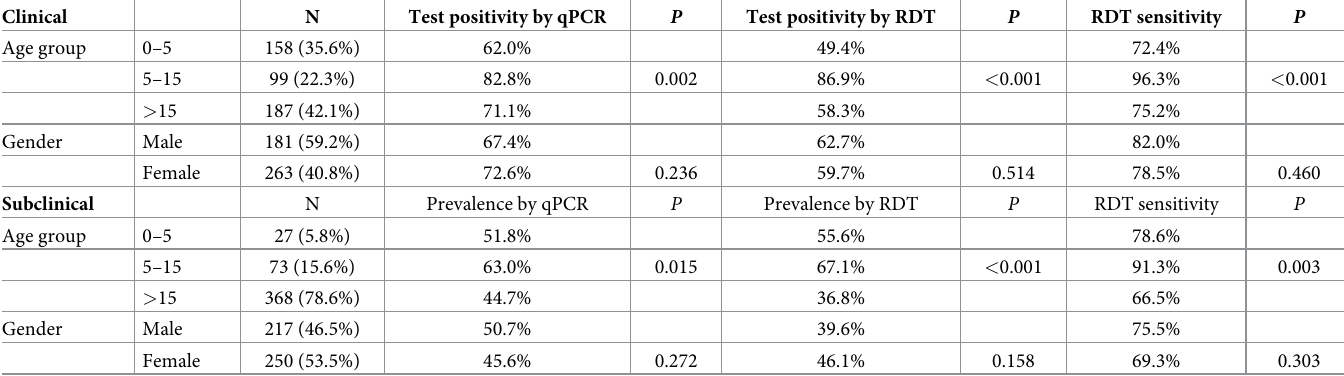
Table 1. Demographics of study population and prevalence and test positivity (by qPCR and RDT) by age group and